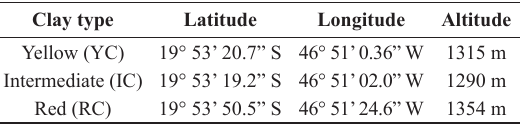
Table 1. Geographic location of samples.